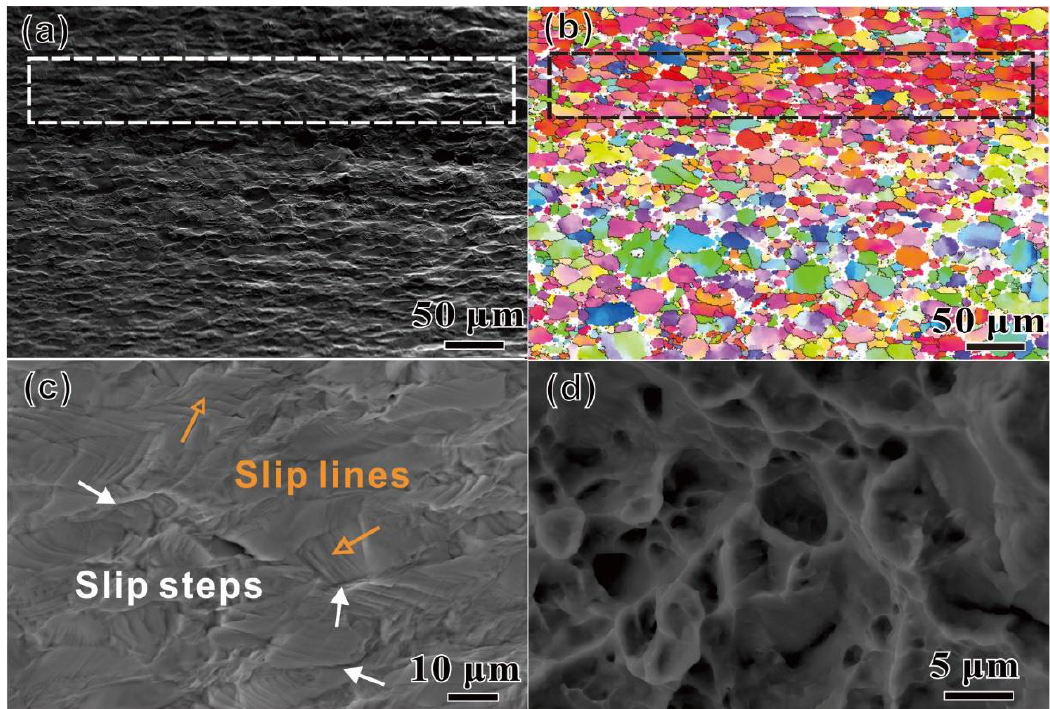
Figure 5. Surface characterization of the fractured specimens. ( a ) SEM and ( b ) EBSD images with macro zone after fracture. ( c ) SEM observation images of the surface morphology of the tensile specimens, and ( d ) the fracture surface.